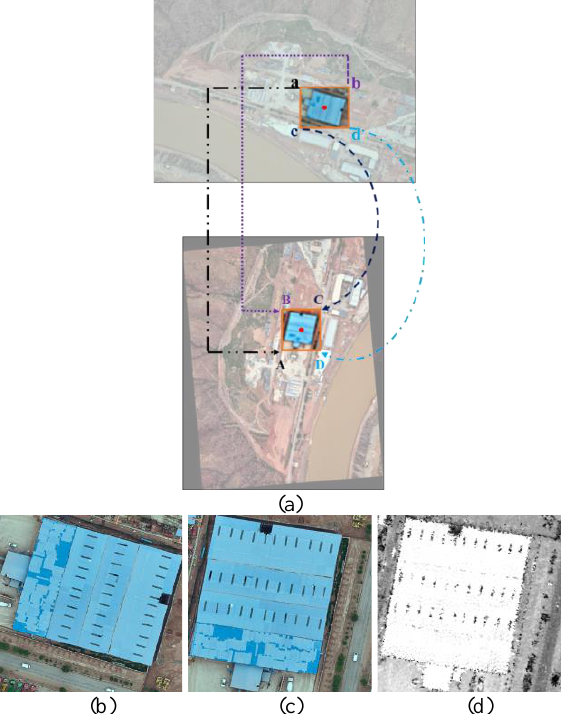
Figure 4. Processing chain of local geometric correction. (a) Schematic of local geometric correction. (b) Aerial image patch before local correction. (c) Aerial image patch after local correction. (d) LiDAR intensity image patch.